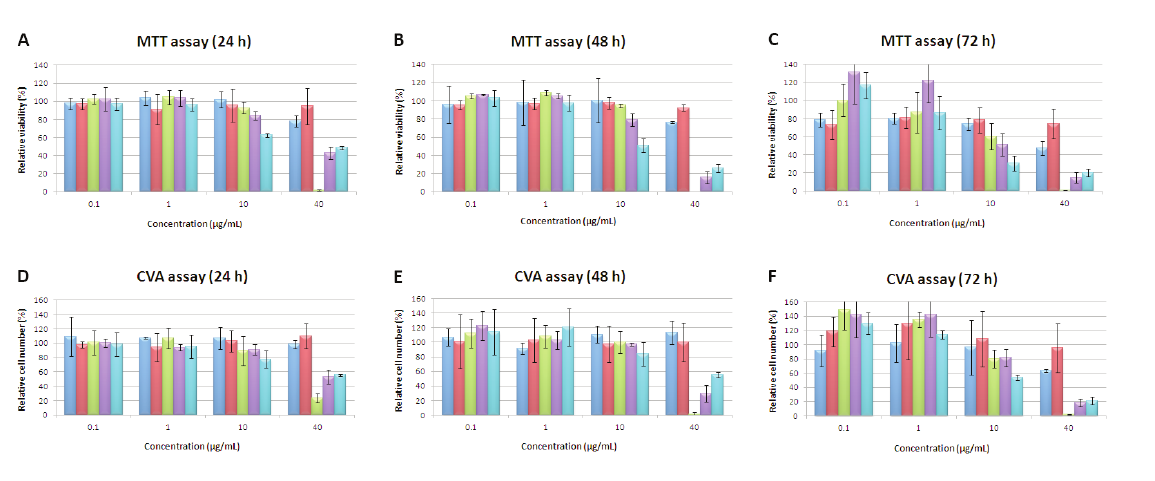
Figure 3. Cytotoxic effect of H. magnifica , H. crispa , H. malu , C. adhaesivum and E. quadricolor (each represented individually as bars from left to right respectively) on the A431 cell line measured by the MTT and crystal violet assays. Data are shown as mean ±SEM of three separate experiments. Treatments significantly different from the untreated control at p < 0.05 are presented as